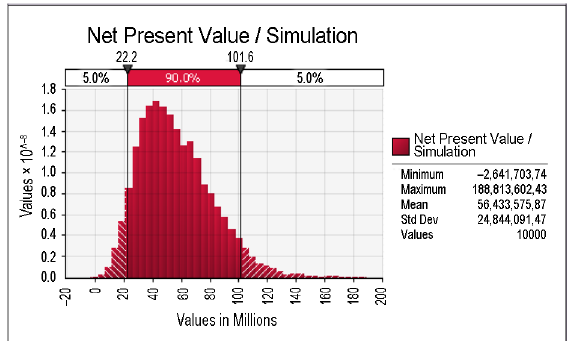
Fig. 2. Probability distribution for Net present value